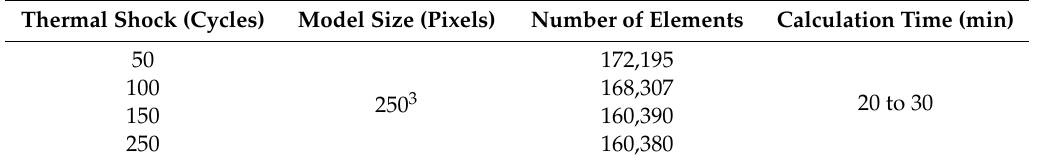
Table 3. Information about elastic modulus simulation.